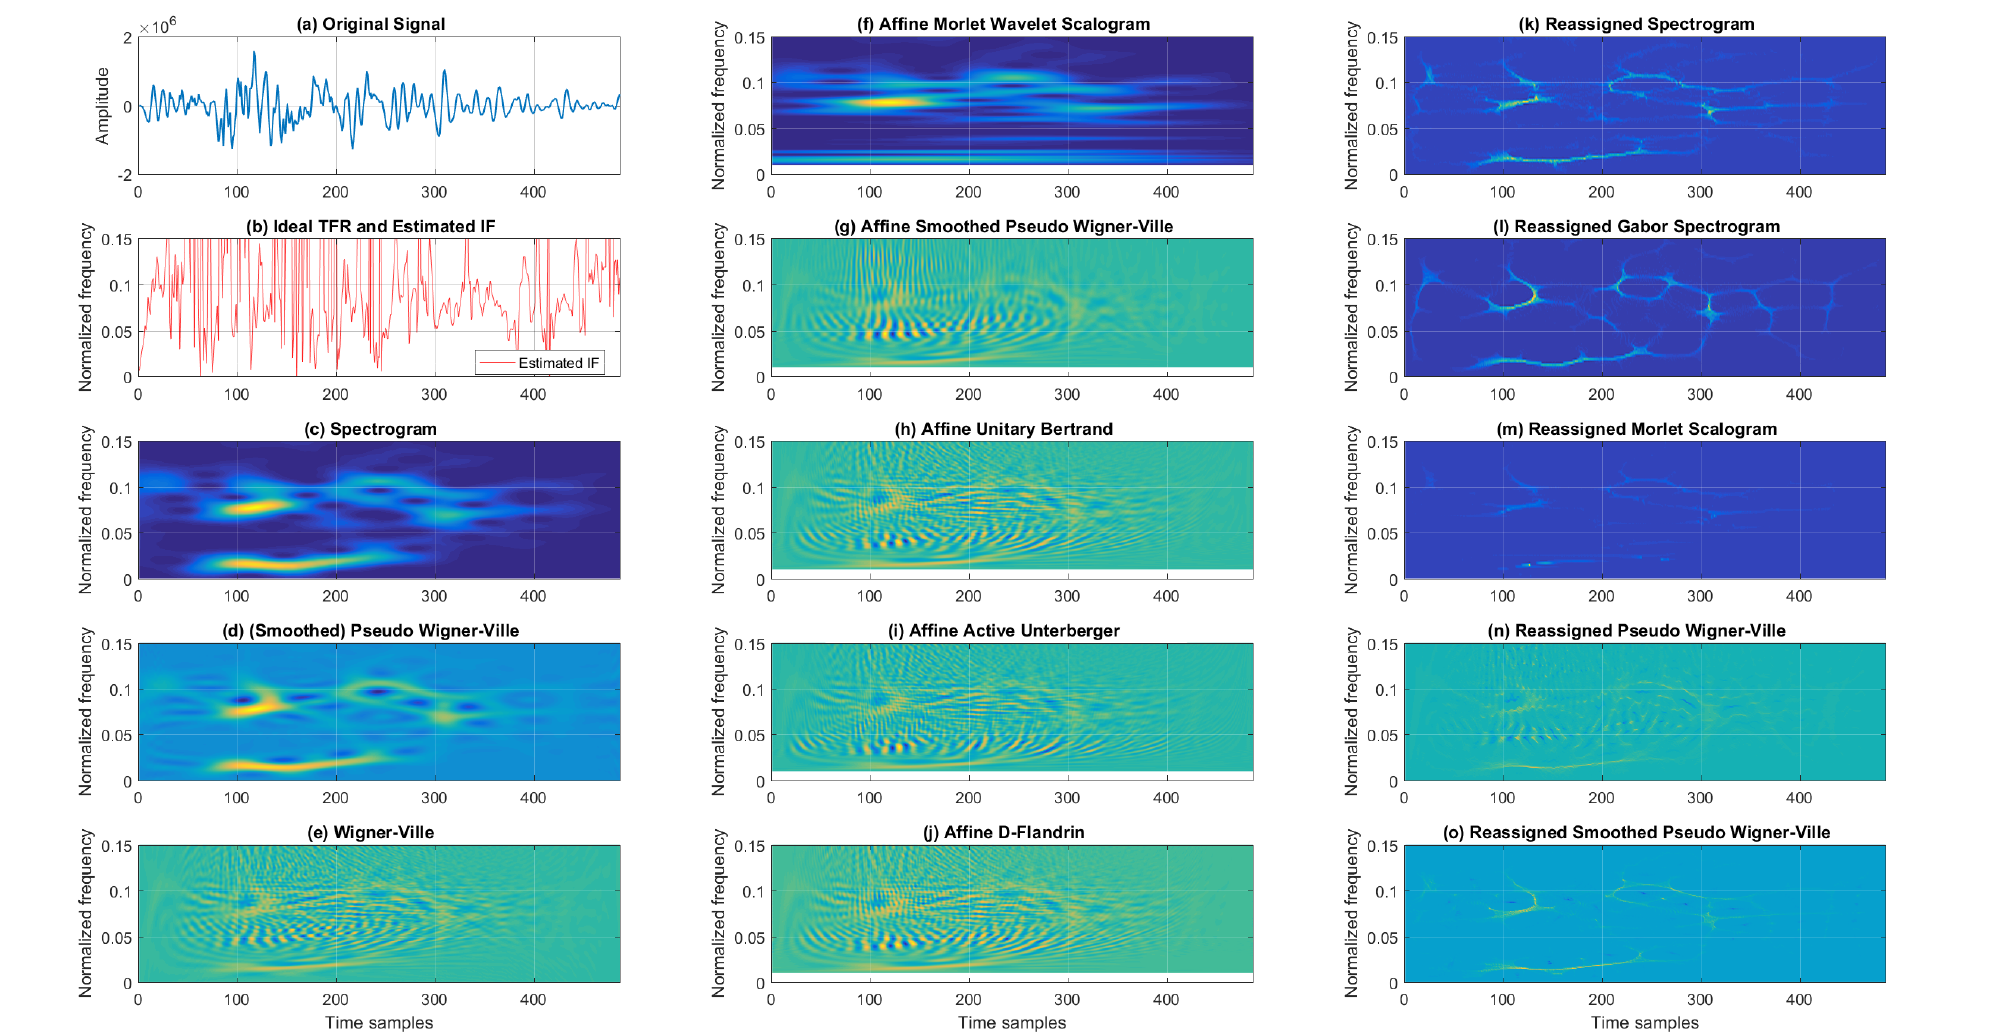
Figure 8. TFRs of the 2020 Zagreb earthquake vertical acceleration